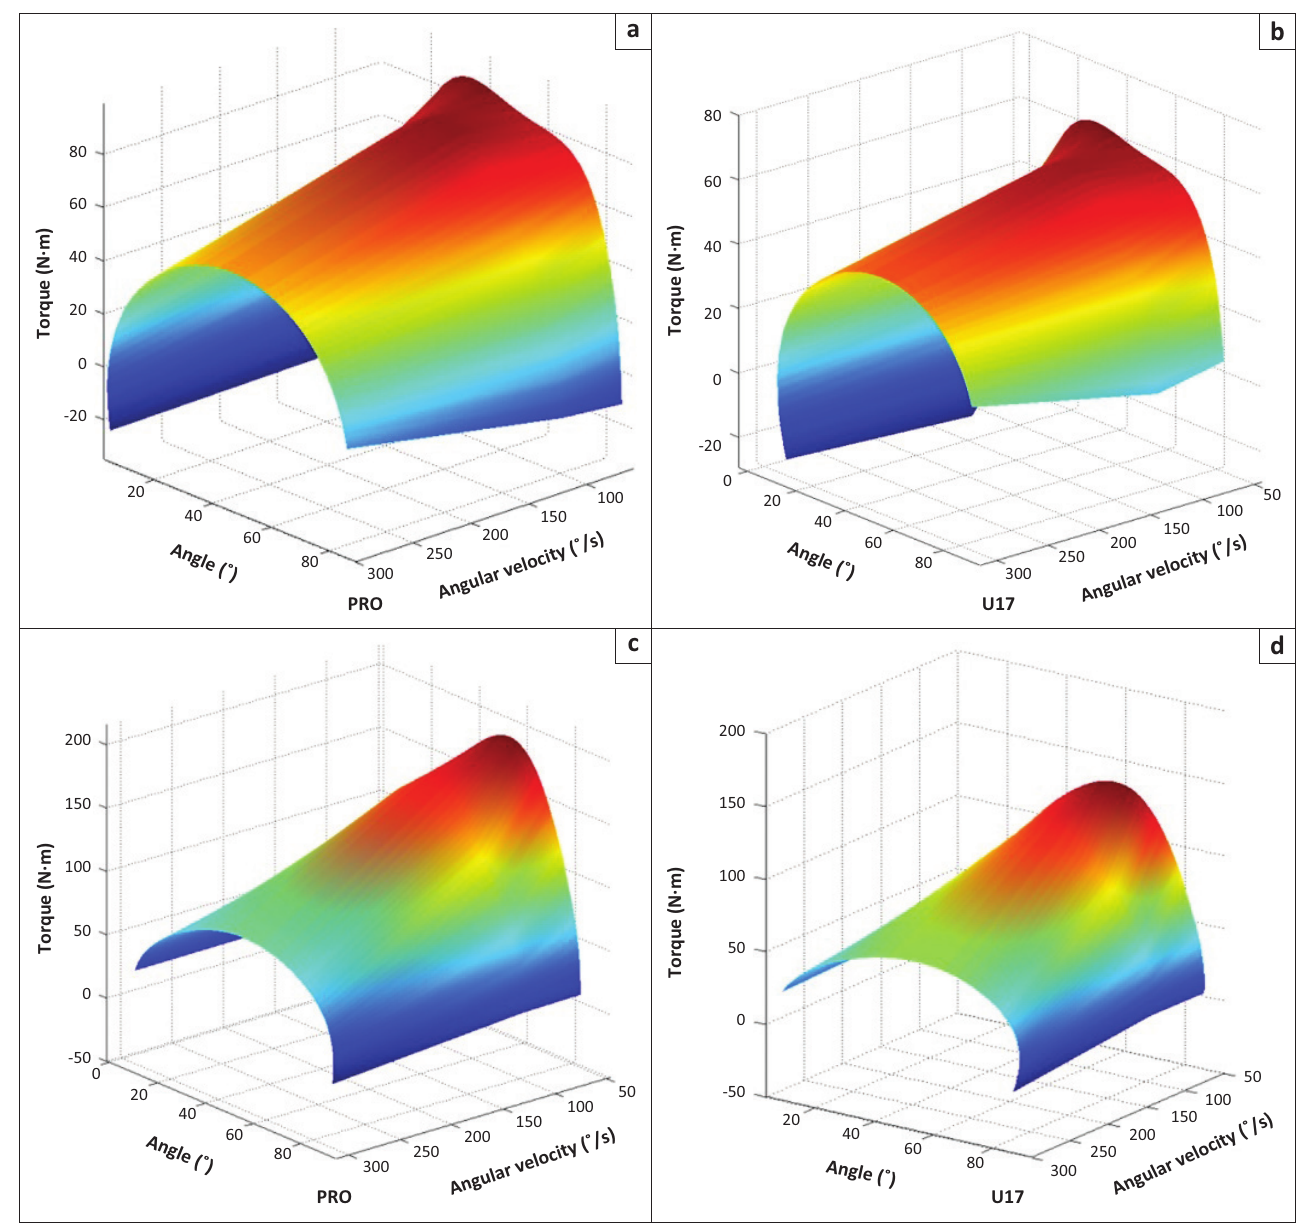
N·m, Newton-metre; °/s, degrees per second; °, degree.